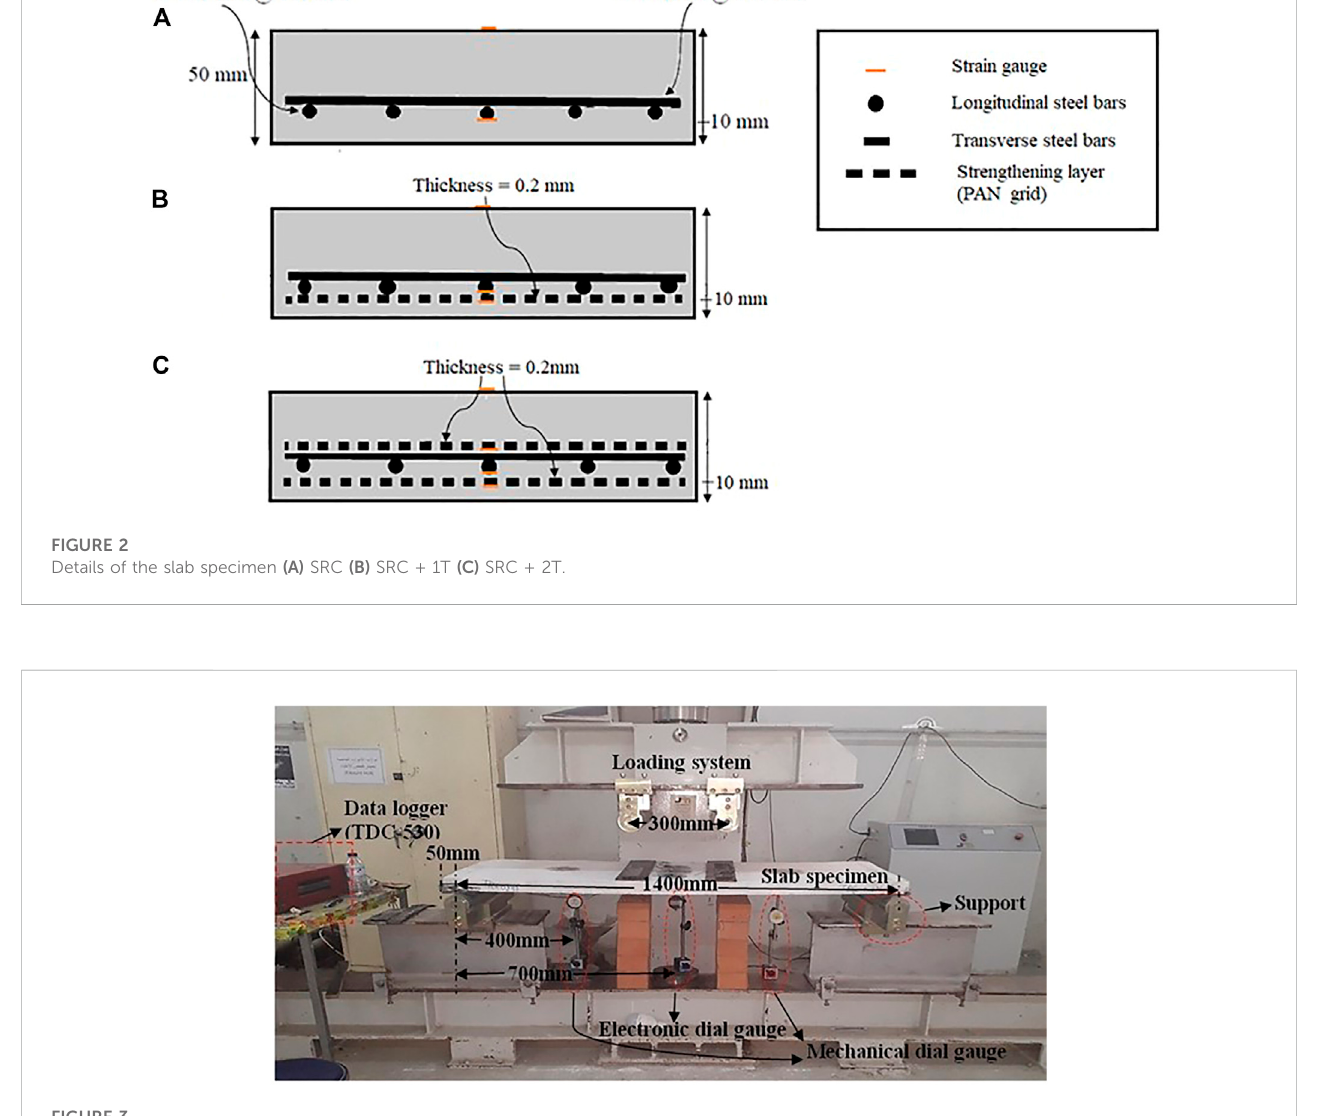
FIGURE 3 Laboratory setup for the four-point bending test of the slab